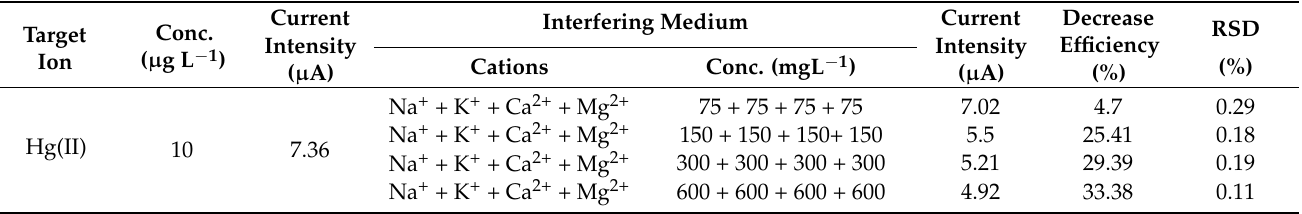
Table 3. Interference study of Hg (II) with different concentrations of alkali and alkaline earth metal ions. The conditions applied were: biomass concentration 5%; Hg (II) concentration 10 µgL − 1 ; alkali and alkaline earth metals concentration 300–2400 mgL − 1 ; pH 7; stripping media 0.1 M HCl; and deposition potential − 0.7 V.